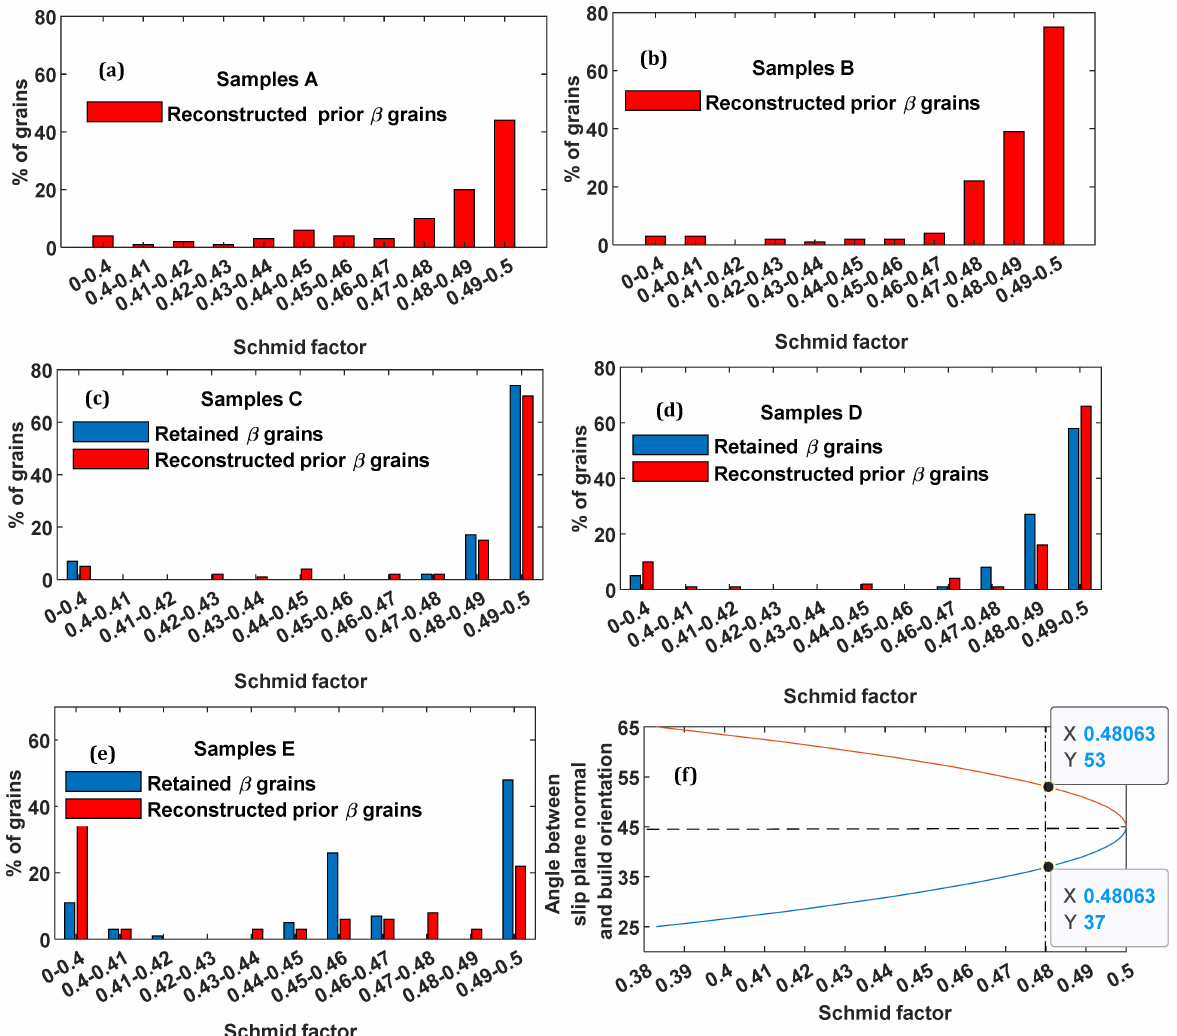
Figure 13. Statistical distribution of the global Schmid factor for reconstructed prior β -grains in samples ( a ) A, ( b ) B, ( c ) C, ( d ) D and ( e ) E, and retained β -grains in samples ( c ) C, ( d ) D and ( e ) E, while ( f ) is a plot of the global Schmid factor against the angle between the slip plane normal and the build